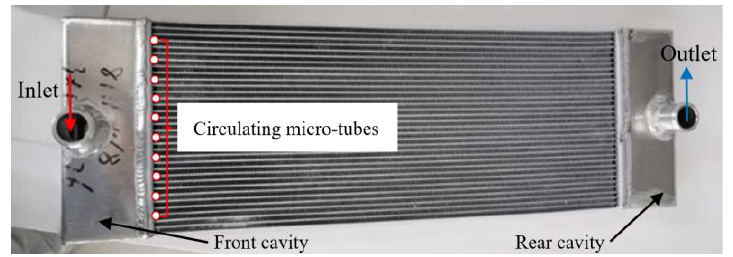
Figure 5. long micro-tubes heat sink.